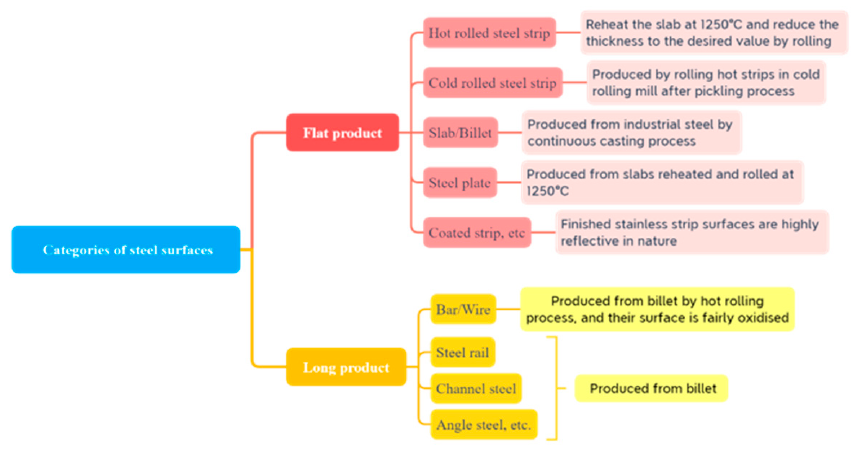
Figure 1. Categories of steel products.